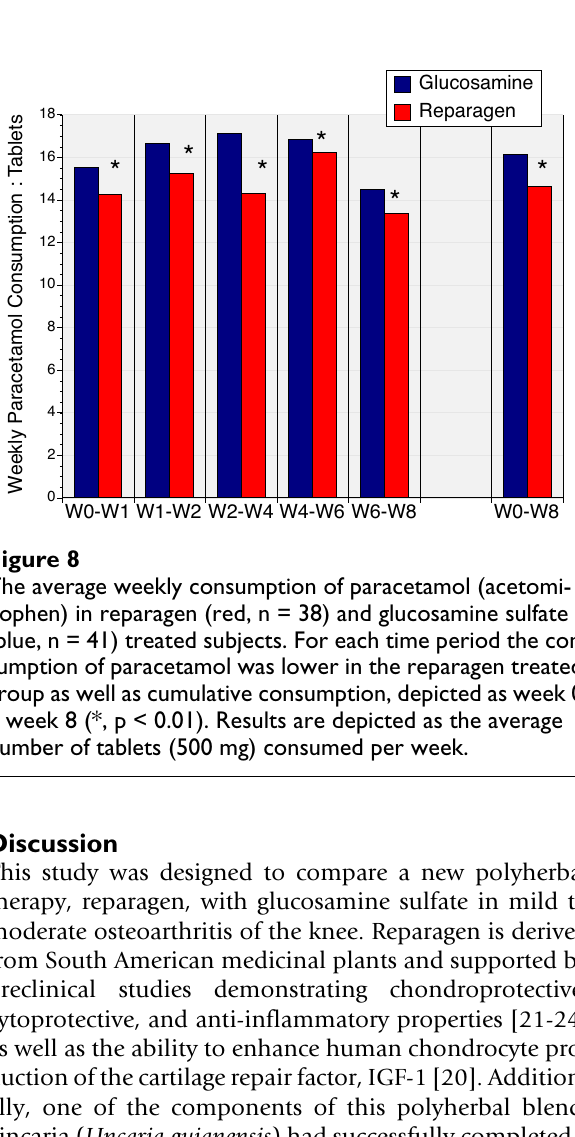
number of tablets (500 mg) consumed per